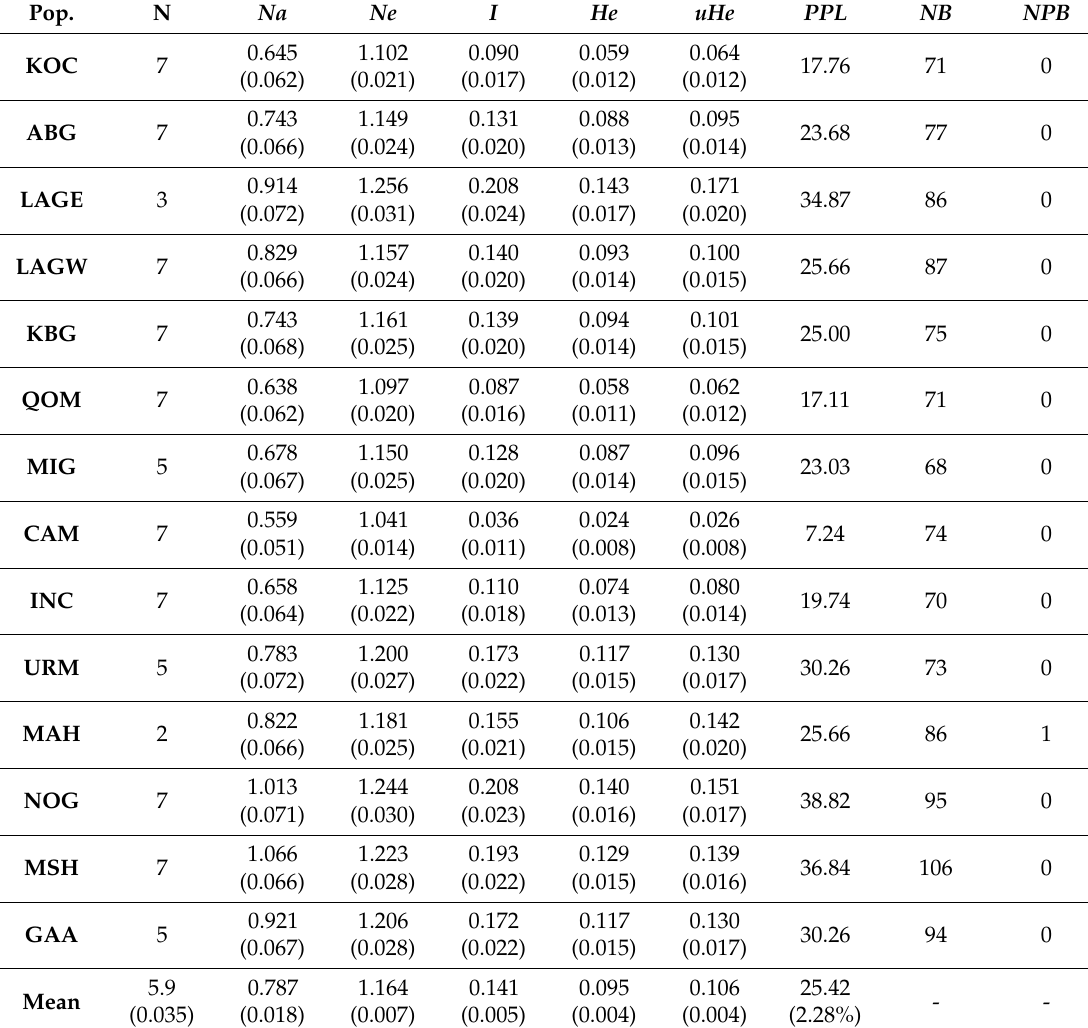
Table 4. Genetic indices among examined populations according to ISSR